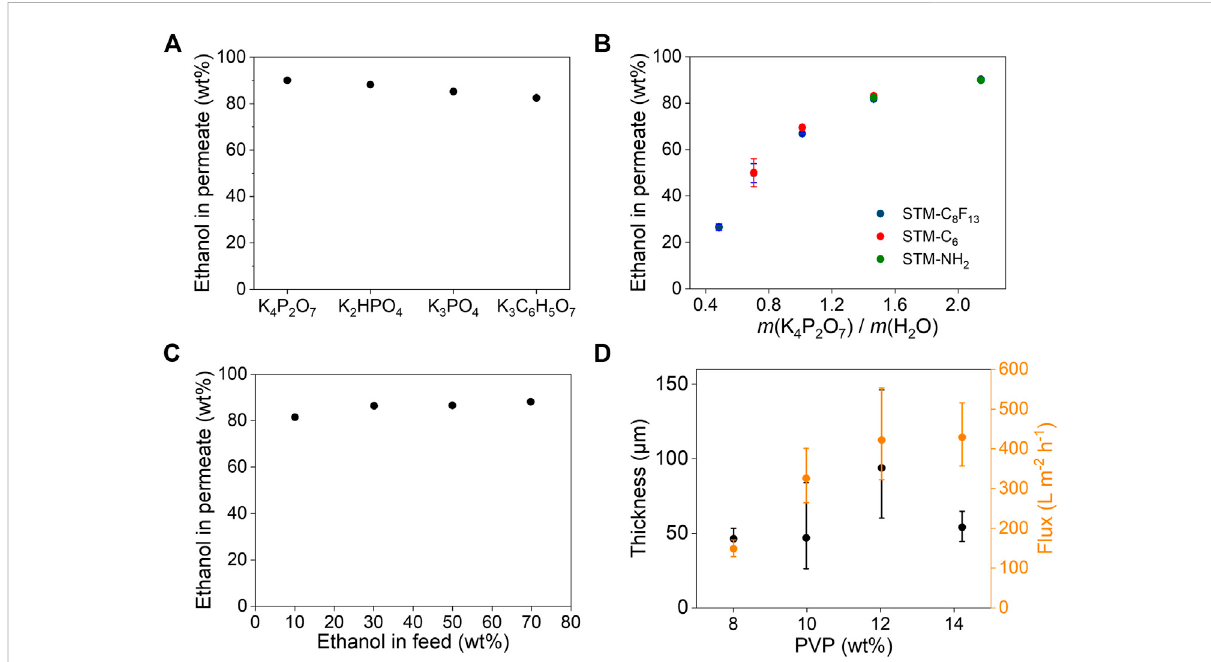
FIGURE 3 Separation performance for ethanol/water. (A) Separation ef fi ciencies of SMS-C 8 F 13 with different saturated potassium salts solutions as the inductive agents. Ethanol in feed is 10 wt%. (B) Separation ef fi ciencies of three different SMSs with different amount of K 4 P 2 O 7 . (C) Separation ef fi ciencies of SMS-C 8 F 13 for ethanol/water with different compositions in the presence of saturated K 4 P 2 O 7 solution. (D) Separation fl uxes and thicknesses of STM-C 8 F 13 prepared using different PVP concentrations. Ethanol in feed is 50 wt%. Inductive agent is saturated K 4 P 2 O 7 solution. The fl ow was driven by the gravity of 1 cm high liquid. Error bars represent the standard deviation form at least three independent